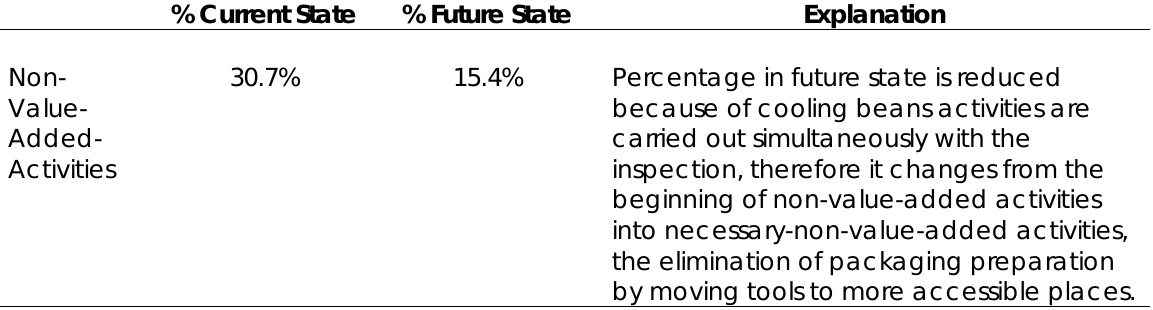
Comparison of Current State and Future state Production